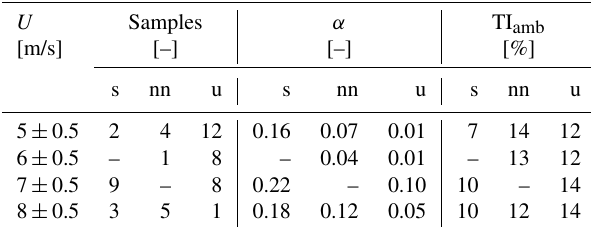
Table 2. Similar to Table 1 but for Strategy II